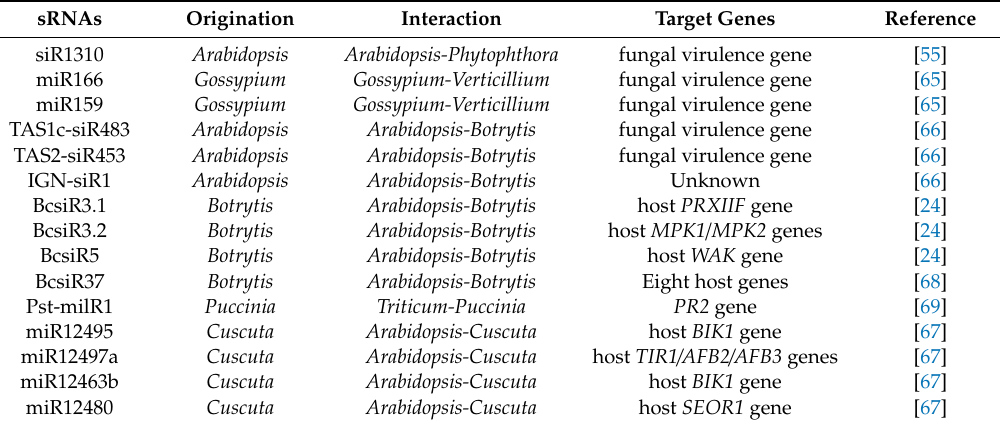
Table 1. Cross-kingdom tra ffi cking sRNAs in plant-pathogen